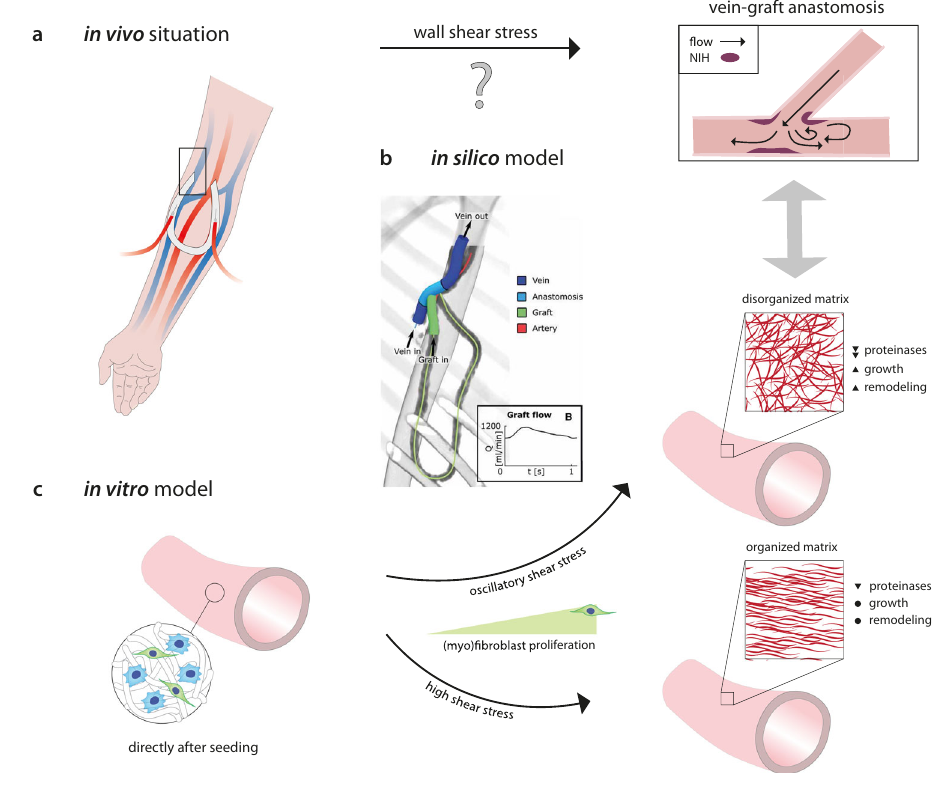
Fig. 1 Proposed role of shear stress on in vivo neointimal hyperplasia, as revealed from a combined in silico and in vitro study. a In vivo, neointimal hyperplasia at the venous anastomosis of vascular access grafts is a common occurrence. This pathology is presumably driven by shear stress. b Using in silico models (i.e., computational fl uid dynamic (CFD) and fl uid – structure interaction (FSI) models), the mechanical environment (i.e., the shear stresses and strains) in vascular access grafts is computed. c The results of these in silico models are used to de fi ne the boundary conditions for the in vitro model (i.e., a 3D scaffold containing macrophages and (myo) fi broblasts), in which the computed shear stresses and strains are recapitulated. After 14 days of dynamic culture, allowing for (myo) fi broblast proliferation and tissue formation, oscillatory shear stress resulted in a reduction of several proteinases and upregulation of growth and remodeling markers, which was accompanied by a dense and disorganized appositional matrix structure. This in contrast to high shear stress, which led to a strongly aligned appositional matrix. Note that in the in vitro study the shear stress and matrix alignment did not occur at the luminal side but at the outside of the scaffold. b is reproduced from Quicken et al. 15 with